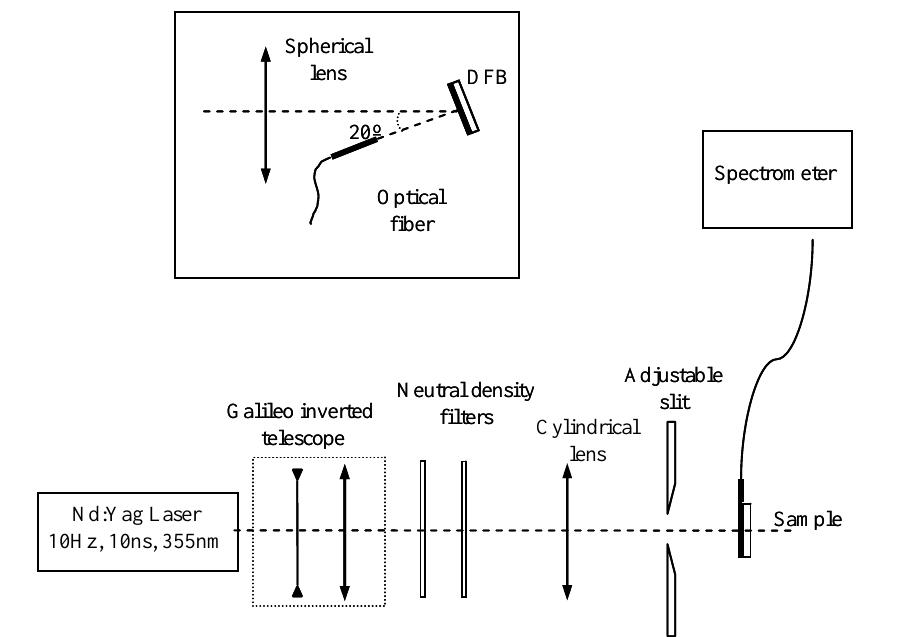
Figure 10. Experimental setup for characterizing the presence of stimulated emission in waveguide configuration. Inset: Detail of the pump and recording configuration in the case of DFB